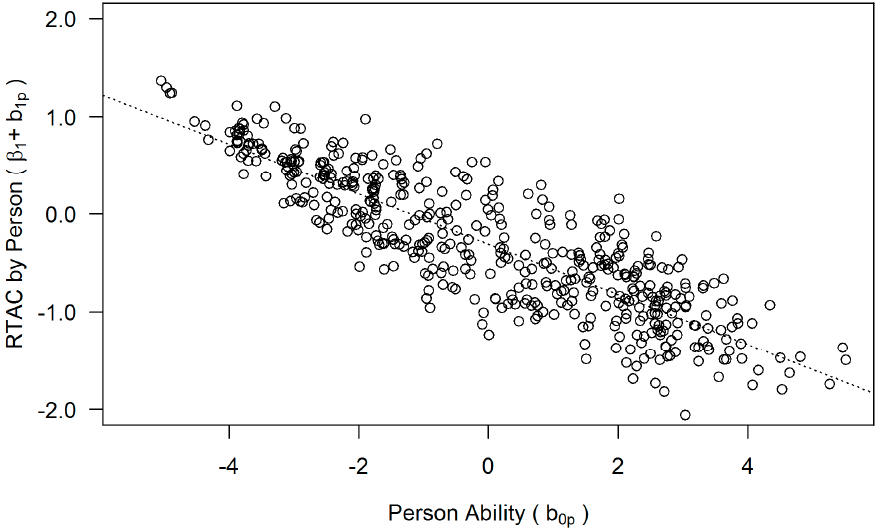
Figure 4. Item RTAC by person ability.